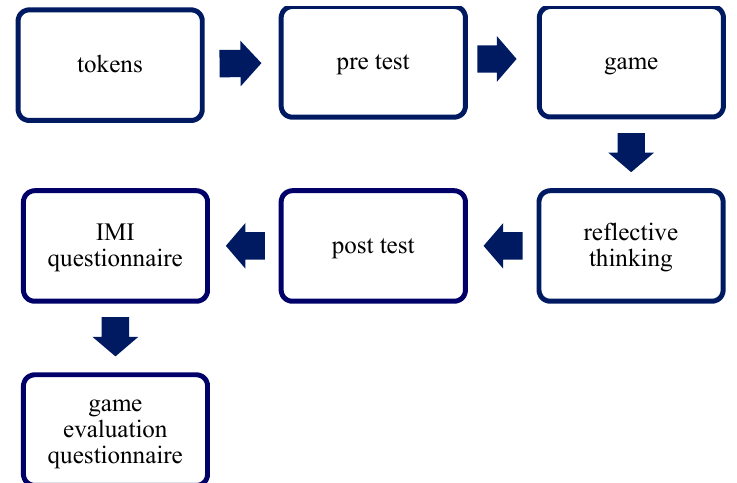
Figure 4. Experimental group’s process.